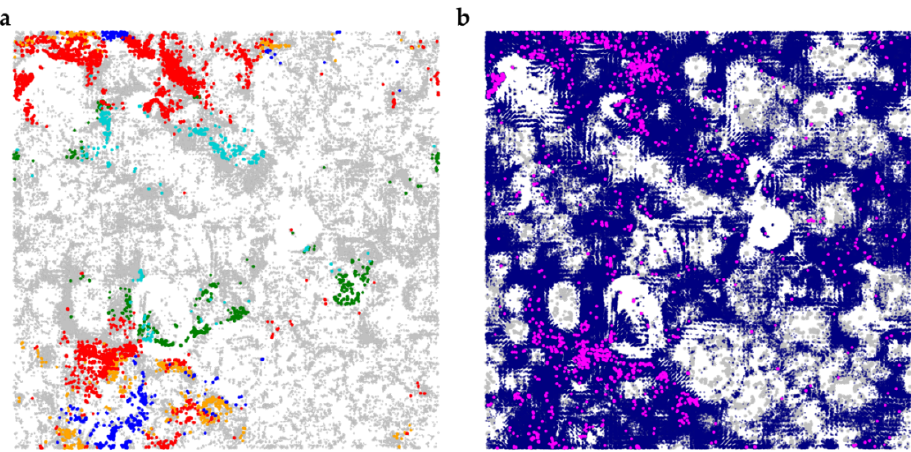
Figure 4. Comparison of the chemical spaces of natural products from CoCoNut database (only CxHyOz), compounds active against Nrf2 and generated compounds using self-organizing map (SOM) (100 × 100 neurons, FragFp fingerprints, see Materials and Methods for details). ( a ) The SOM built on CoCoNut compounds colored by most frequent scaffolds (see Table S7). Red—benzene ring, cyan—sterone ring, orange—coumarin, blue—flavone, green—tetrahydropyran, grey—compounds bearing other scaffolds. Markers for compounds bearing frequent scaffolds were enlarged for better visibility. ( b ) The SOM built on CoCoNut compounds (grey) on which generated compounds (dark blue) and compounds active against Nrf2 (magenta) were projected. Markers for CoCoNut compounds and compounds active against Nrf2 were enlarged for better visibility.